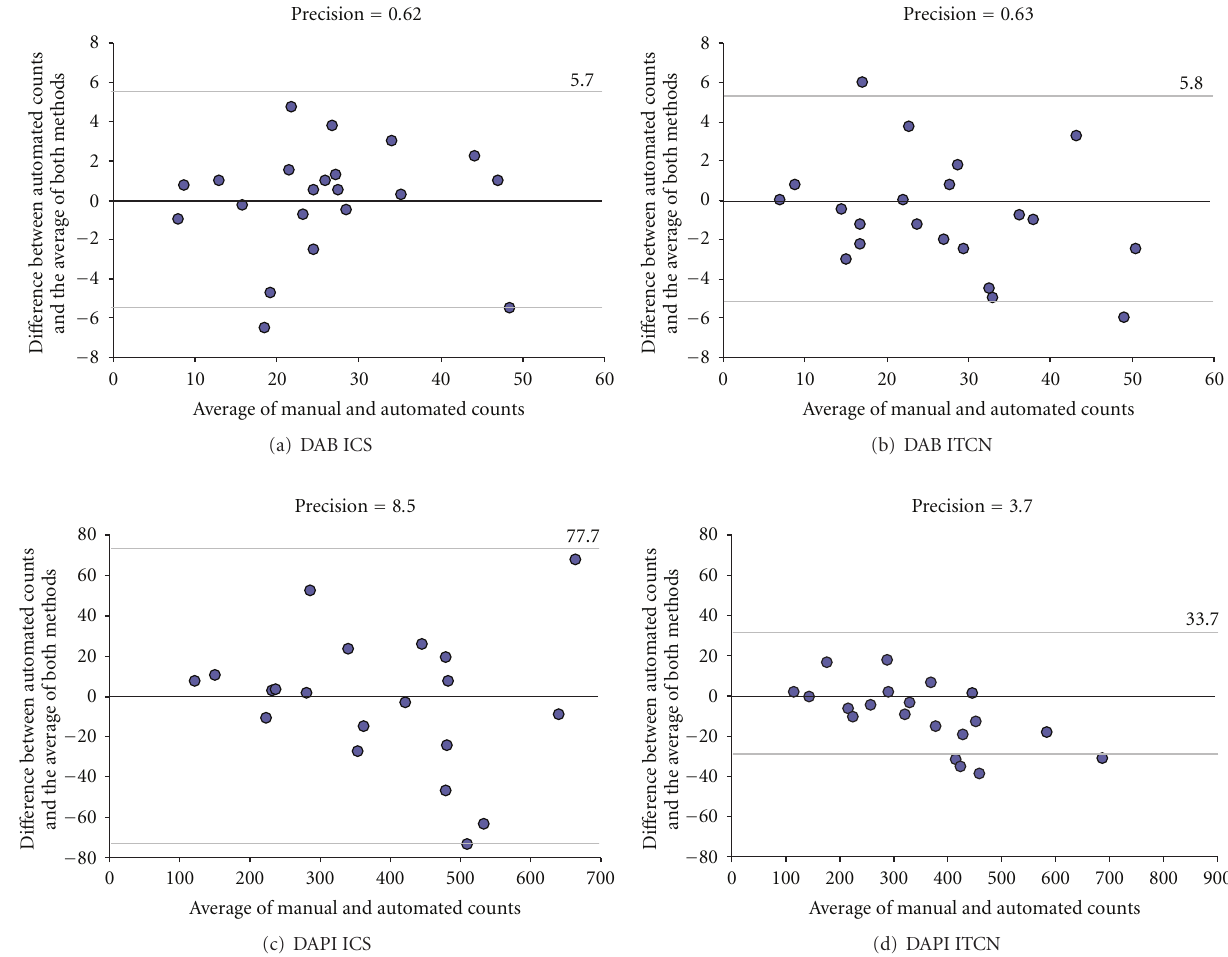
Figure 10: Bland-Altman plots of ICS and ITCN. ( a) Di ff erence between ICS counts and the average of all counts for DAB-stained samples. (b) Di ff erence between ITCN counts and the average of all counts for DAB-stained samples. (c) Di ff erence between ICS counts and the average of all counts for DAPI-stained samples. (d) Di ff erence between ITCN counts and the average of all counts for DAPI-stained